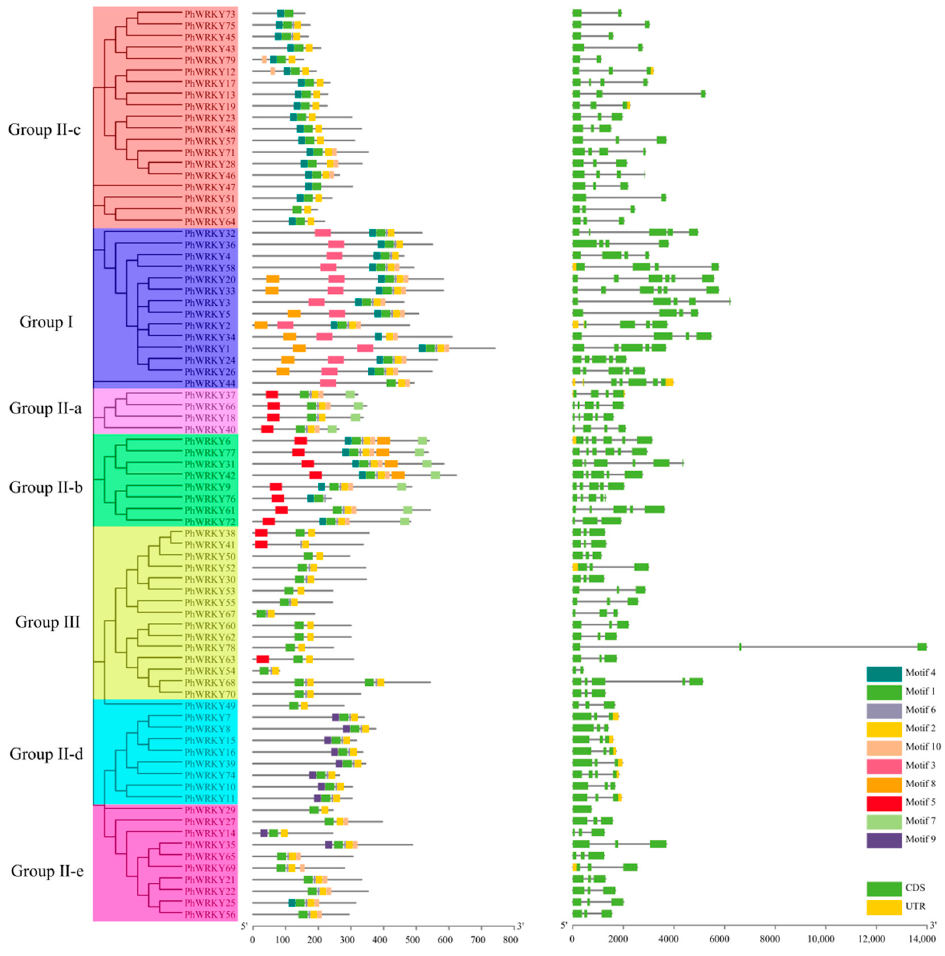
Figure 2. Sequence analysis and gene structure of PhWRKYs.